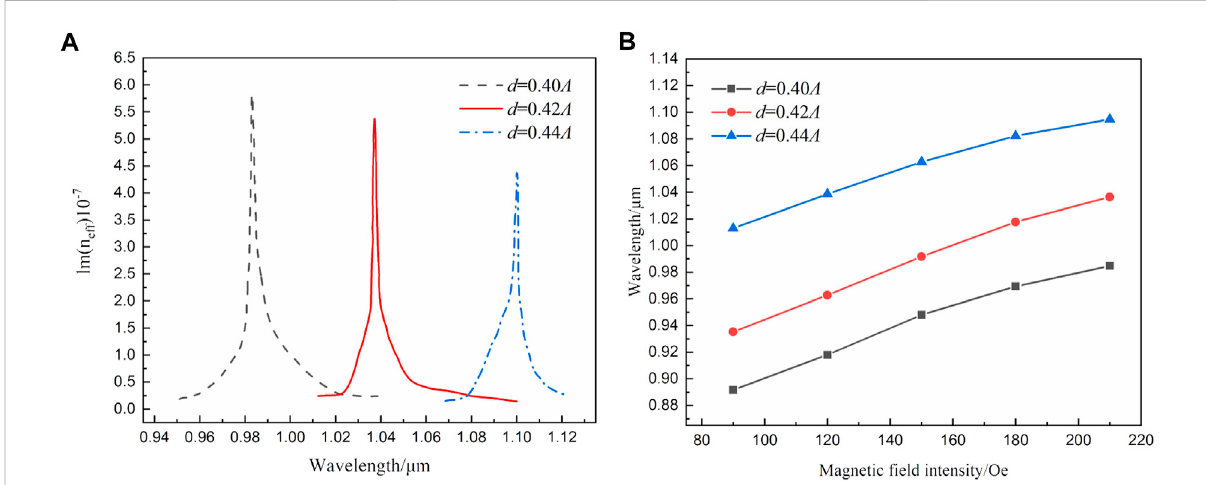
FIGURE 9 In fl uence of different air hole diameter d on sensing characteristics under directional coupling effect by setting N = 3, Λ = 8 μ m, t = 40 nm. (A) The loss curves of core mode for different d. (B) The resonance wavelength with magnetic fi eld intensity for different d.